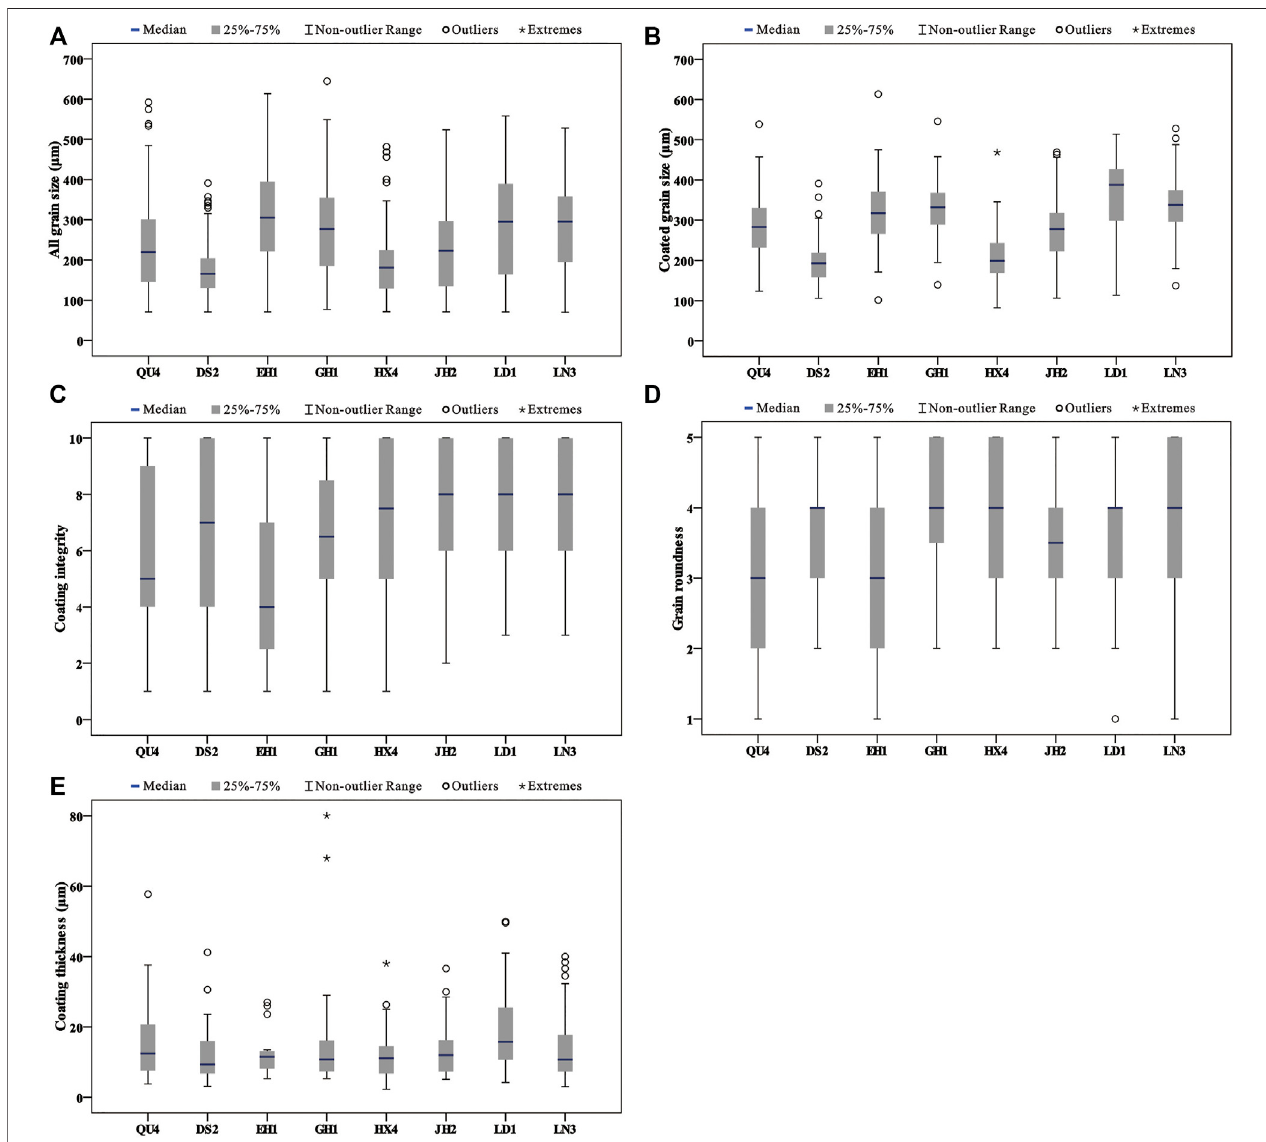
FIGURE4| Resultsforgrainandcarbonatecoatcharacteristics forthesamplesfromthelakeandlagoon. (A) Resultsforallgrainsizesinthesamplesfromthelake and lagoon. (B) Results for coated grain sizes in the samples from the lake and lagoon. (C) Results for coating integrity in the samples from the lake and lagoon. (D) Results for grain rounded in the samples from the lake and lagoon. (E) Results for coating thickness in the samples from the lake and lagoon.